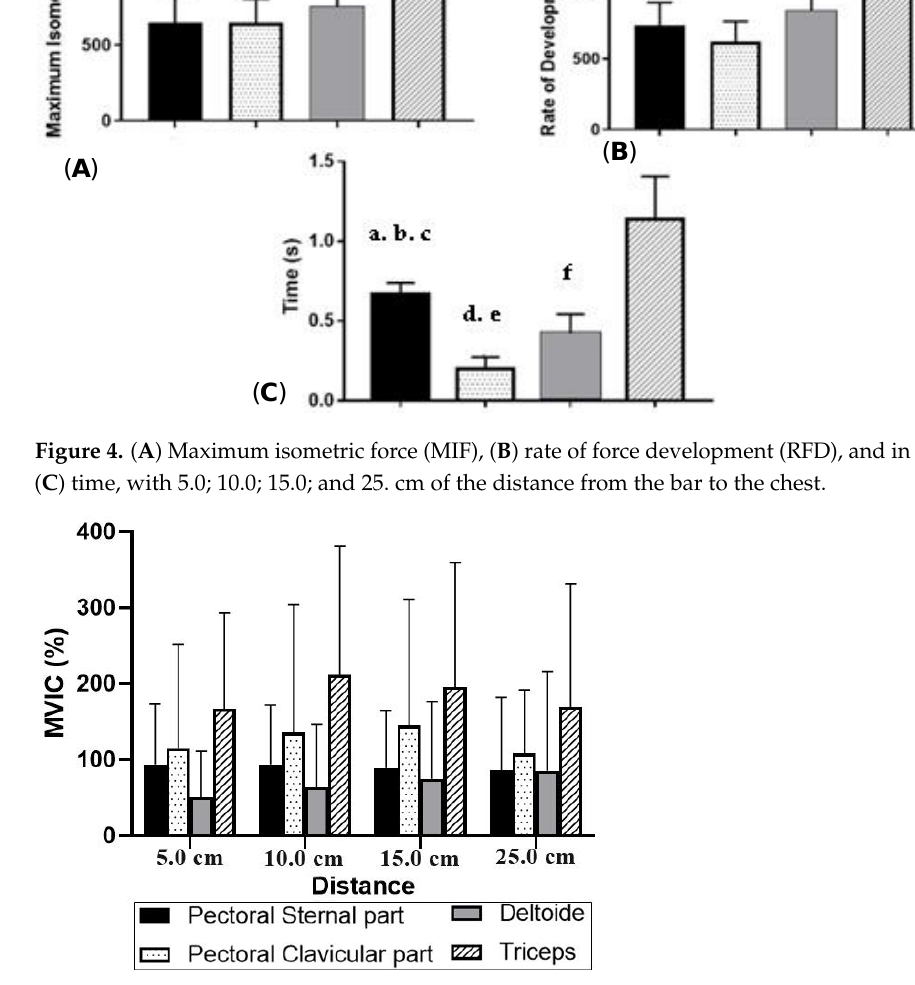
Figure 5. Electromyography of the pectoral, sternal and clavicular parts, deltoid and triceps at different distances from the chest. Legend: MVCI: maximal voluntary isometric contraction (%).